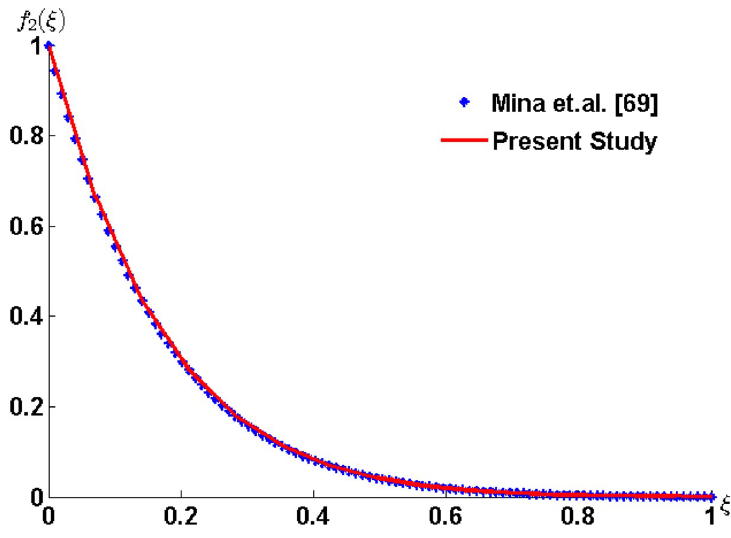
Fig 5. Comparison with Mina et al . [69] in the absence of nanoparticles and for n = 1, α = 0.5, M � = 2 and μ � = 0.1.